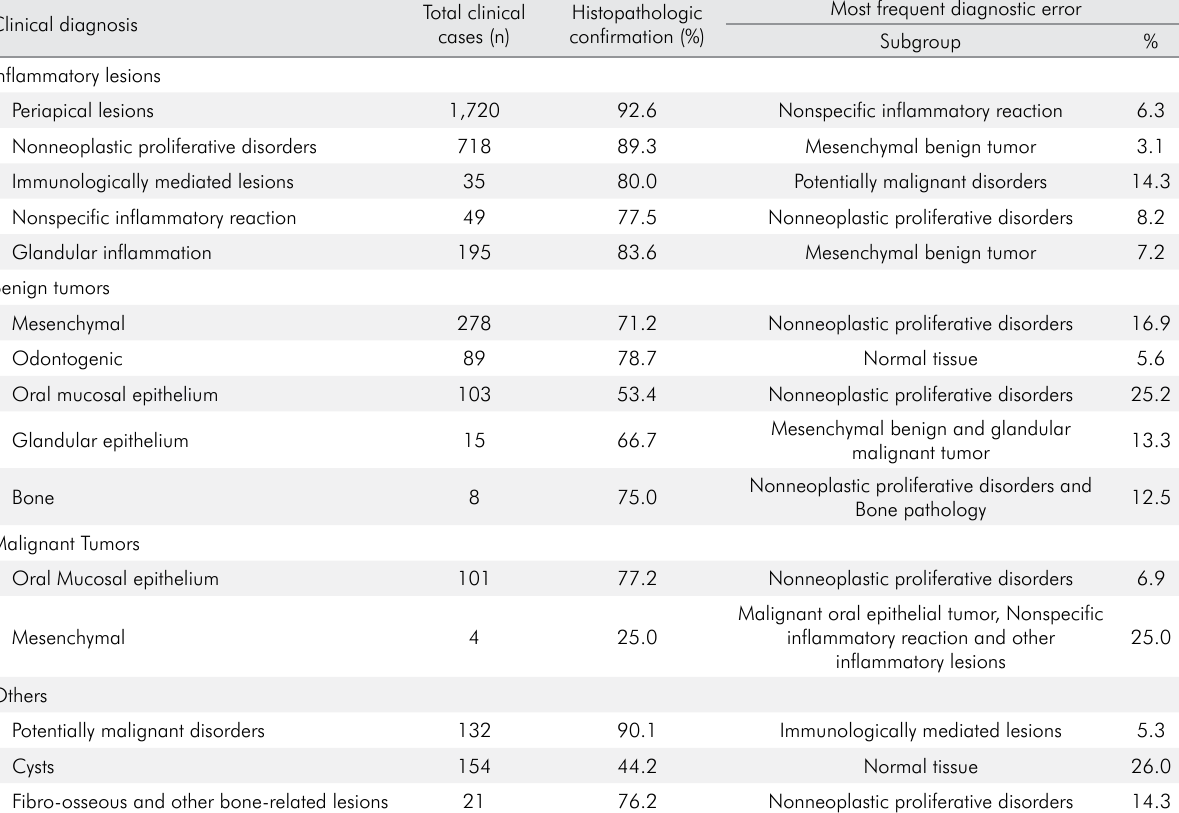
Table 1. Percentage of agreement between clinical and histopathologic diagnoses for each group of clinical diagnosis. Clinical